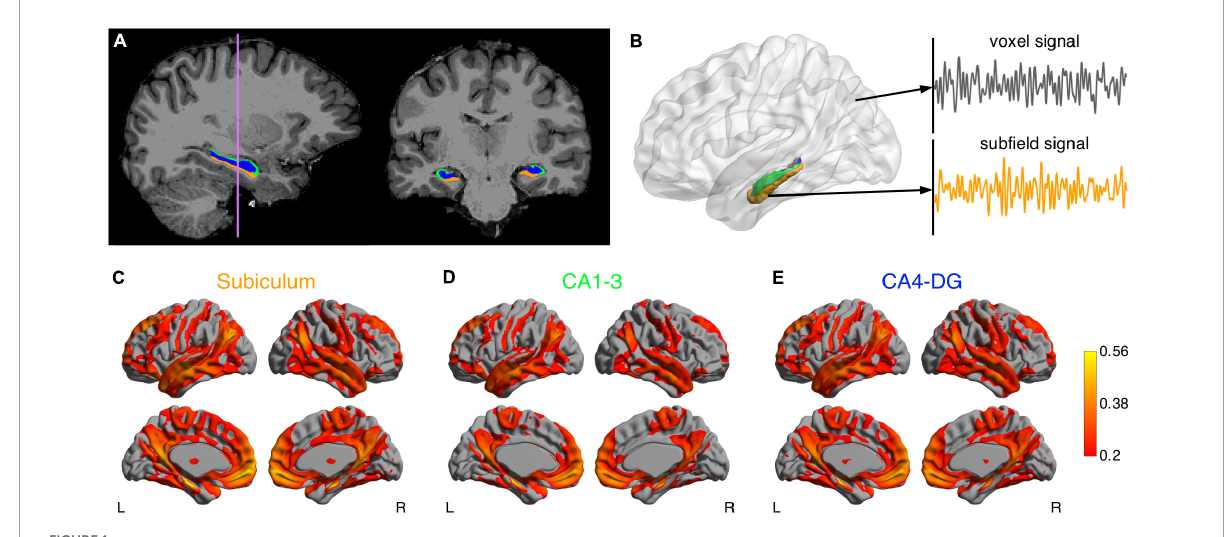
FIGURE1 Analysis pipeline of the hippocampal subfield networks. (A) Segmentations of the subiculum (orange), CA1-3 (green) and CA4-DG (blue) superimposed on T 1 -weighted anatomical image. (B) After data preprocessing, the functional MRI time course was extracted for each voxel. The mean time course of each subfield was also computed as seed signal. Connectivity maps for the subiculum (C) CA1-3 (D) and CA4-DG (E) networks averaged across a group of healthy young